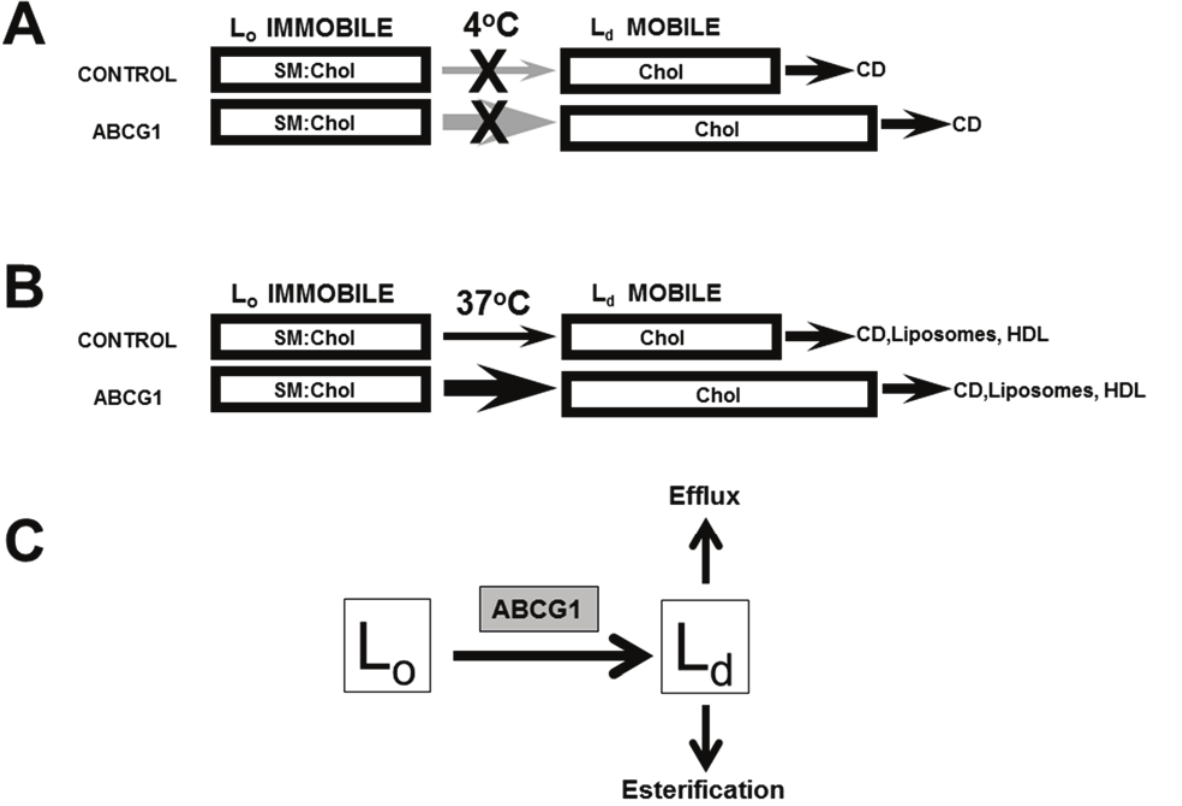
Figure 8. Model of ABCG1-mediated mobilization of cellular cholesterol for efflux and esterification. ABCG1 increases the flux of PM ( A ) and cellular ( B ) cholesterol (FC) between SM-associated FC in L o membrane domains and non-SM-associated FC in membrane domains L d pools. ( A ) At 4 °C, since FC movement from intracellular compartments to the PM as well as movement between L o and L d membrane domains at the PM is blocked, CD removes FC only from mobile L d PM FC pools, which are expanded by ABCG1, as shown. ( B ) At 37 °C, CD, PC liposomes, and HDL remove mobile FC pools from the PM and intracellular compartments, mostly LE. Depletion of mobile FC pools results in the movement of FC from L o to L d membrane domains and subsequent removal by extracellular lipid acceptors from mobile pools. ABCG1 enhances movement of FC between L o and L d membrane domains in the PM and LE, thereby increasing FC efflux. ( C ) ABCG1 residing at the phase boundary between L o and L d membrane domains at the PM and LE appears to increase the rate of flux of cholesterol between L o and L d membrane domains, and therefore the size of the pool available to desorb to acceptors and in addition, may increase the chemical potential of L d cholesterol. The mobile pools of FC in L d membrane domains are available for removal on either side of the membrane lipid bilayer, by extracellular acceptors (efflux), or, by cytosolic carrier proteins, which promote movement to intracellular sites of